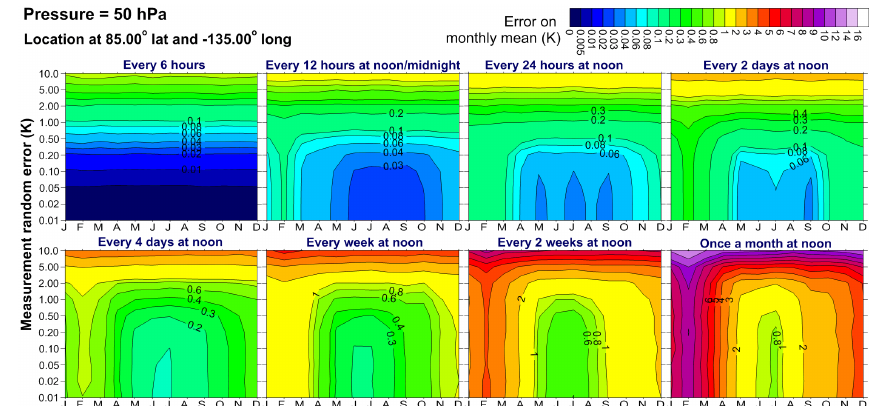
Figure 2. The uncertainty in the monthly mean temperatures at 50hPa, 85 ◦ N, 135 ◦ W, for a range of sampling frequencies, as a function of the random uncertainty in each instantaneous measurement.